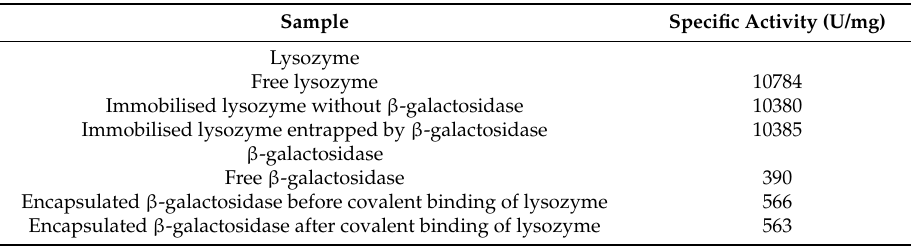
Table 1. The comparison of the specific activities of free and immobilised enzymes.